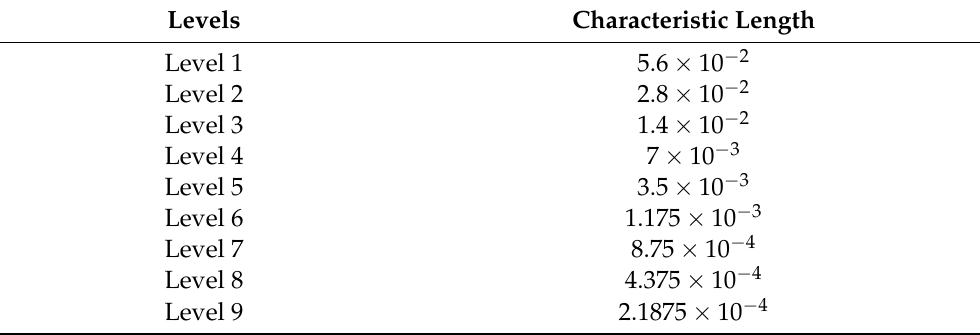
Table 1. Summary of the characteristic lengths of the cells relative to the levels of